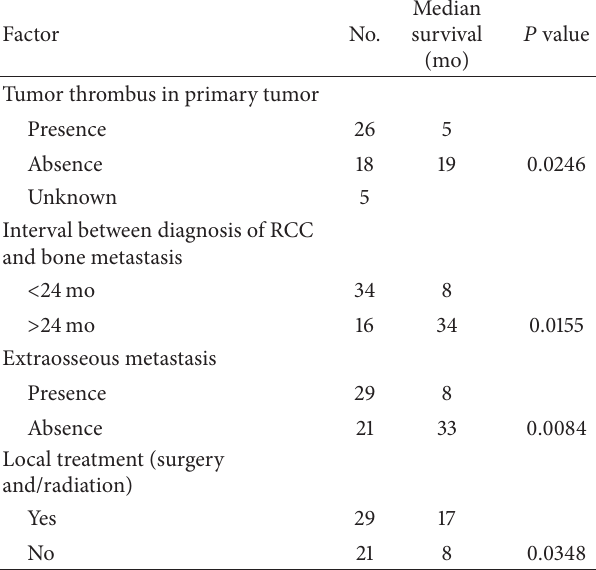
Table 1: Prognostic factors of renal cell carcinoma. Factor No.